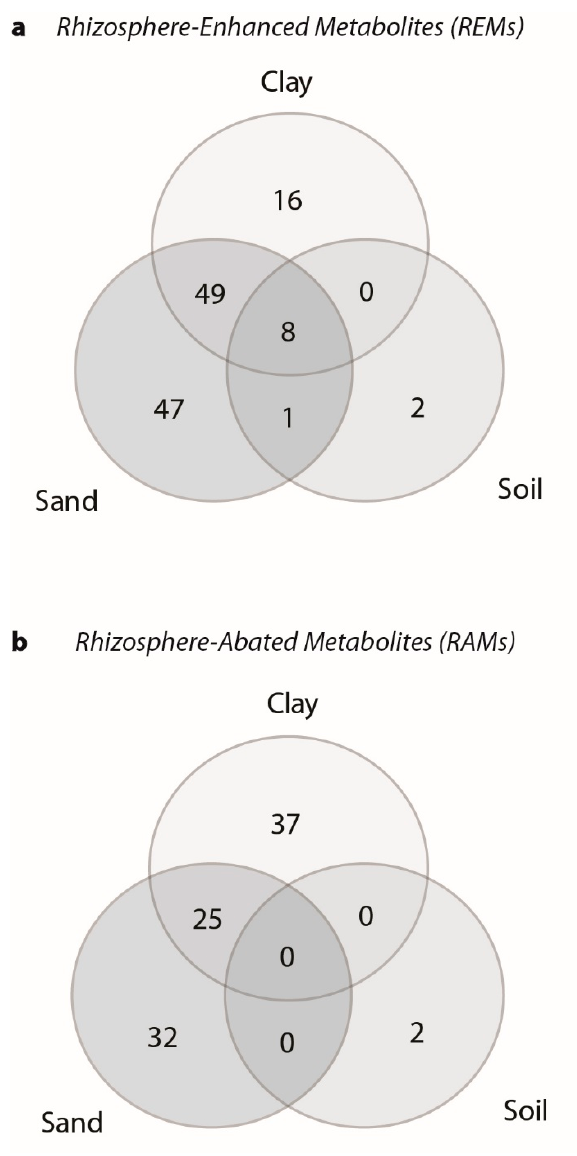
Figure 4. Venn diagram for the number of significant metabolites that were either ( a ) rhizosphere- enhanced metabolites (log 2 FC > 1) or ( b ) rhizosphere-abated metabolites (log 2 FC < − 1). Shading indicates different substrates and the numbers in the overlapping regions represent the number of significant metabolites that are in common.